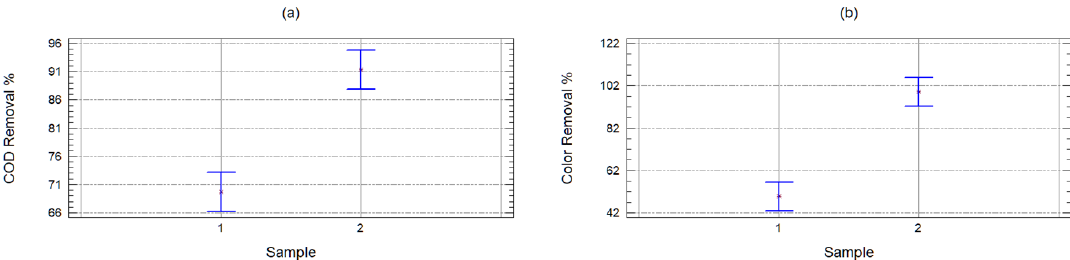
Figure 3. Mean charts of the chemical oxygen demand (COD) (a) and color (b) removal efficiency, according to the type of sample (1 = RL and 2 = FE).